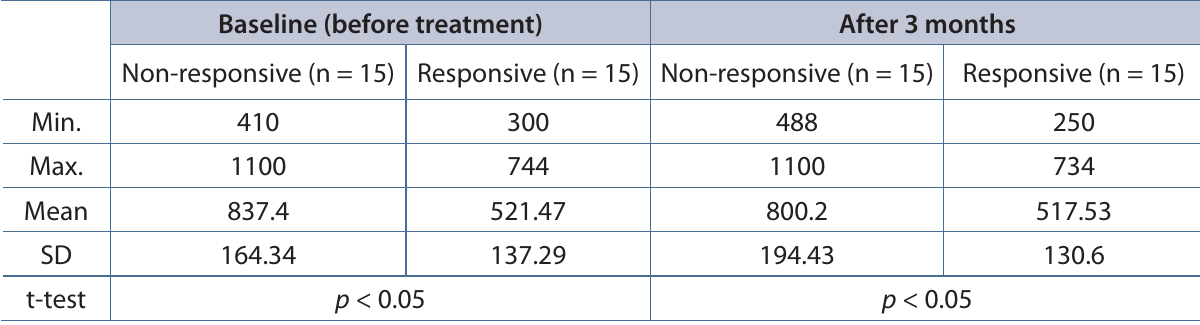
Table 3. Comparison between serum s-VCAM-1 levels (ng/mL) in responsive and non-responsive patients Baseline (before